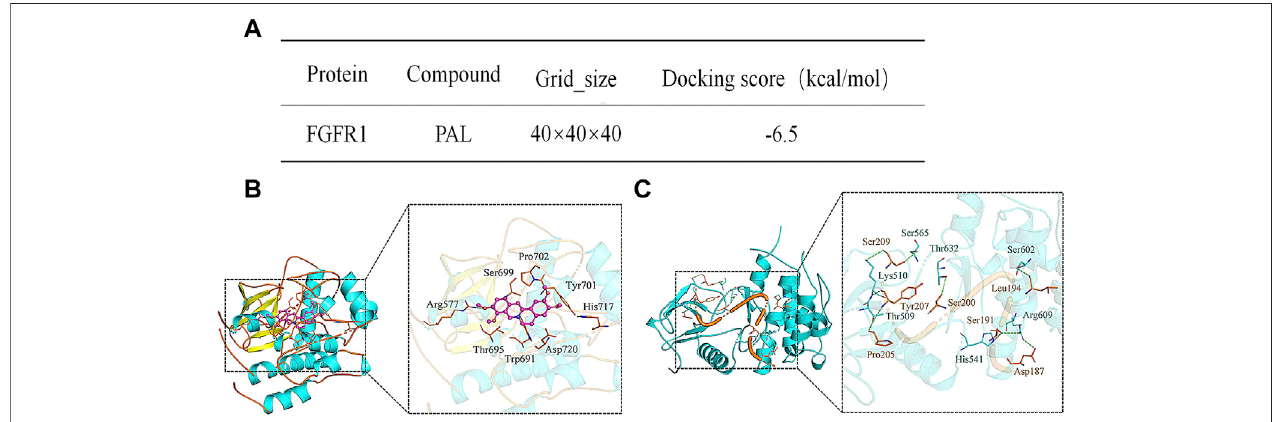
FIGURE 3 | Analysis of the molecular interaction between palmatine (PAL) and fi broblast growth factor receptor 1 (FGFR1). (A) The binding energy between FGFR1 and PAL. (B) A three-dimensional representation of the docking between FGFR1 and PAL. (C) A three-dimensional representation of the docking between FGFR1 and